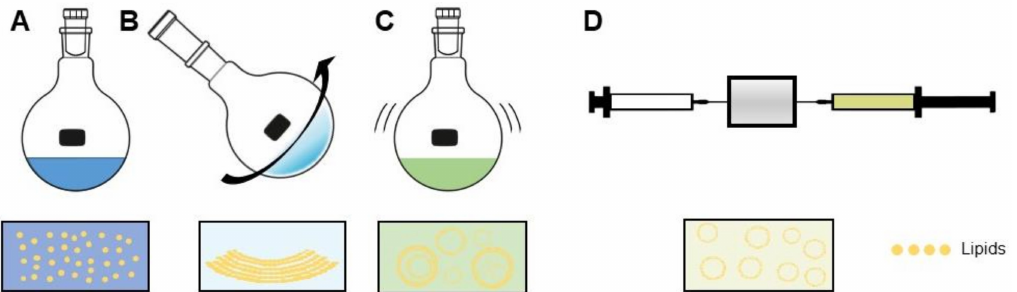
Figure 3. Liposome synthesis using the thin-film hydration method. ( A ) Lipids are combined in desired ratios in organic solvent. ( B ) The solution then undergoes rotary evaporation (dehydration) under negative pressure, causing formation of lipid bilayers. ( C ) The dry lipid film is rehydrated in aqueous buffer with swirling and sonication, which leads to non-uniform formation of MLVs, LUVs and GUVs. ( D ) Finally, extrusion through membranes of sequentially lower pore size forces formation of SUVs within a small size range, having uniform